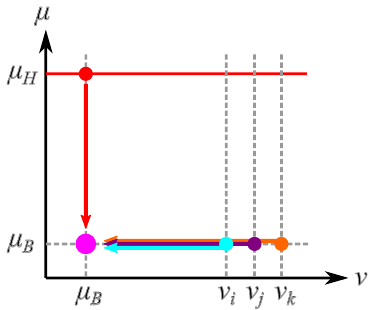
Figure 5. We evolve all ingredients from their natural ( µ, ν ) scale to the scale of the soft function along the indicated paths. We take the different ν i into account though they are of the same parametric